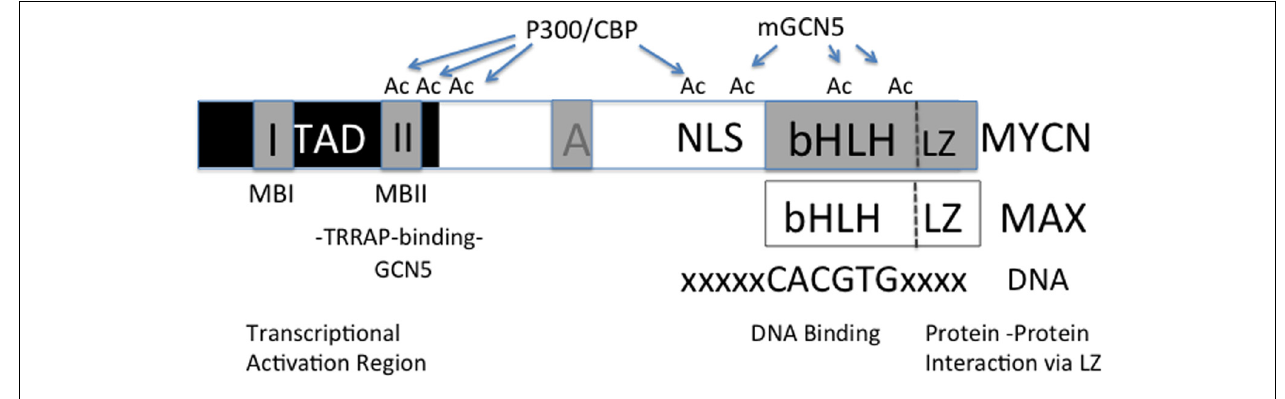
dimerizes with other bHLH containing transcription factors via a carboxy-terminal leucine zipper (Zip) region.While MYC recruits HATs such as GCN5 and CBP/p300 which are known to acetylate lysine residue on histone tails, these HATs are also known to acetylate (Ac) MYC which affects its stability by blocking or competing with ubiquitin ligases that target MYC for